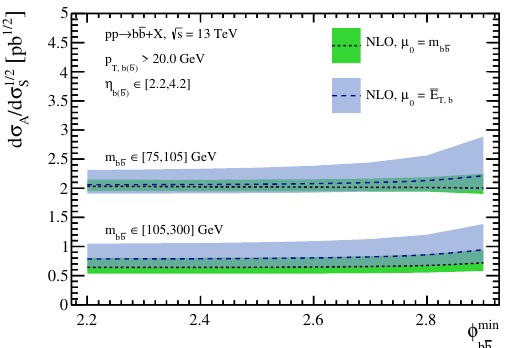
Figure 8 . Asymmetric b (cid:22) b cross section within m normalised to the square root of the symmetric cross section as a function of (cid:30) min predictions correspond to the LHCb (cid:12)ducial region (2.2) at choices introduced in (2.5). The depicted error bands are due to scale